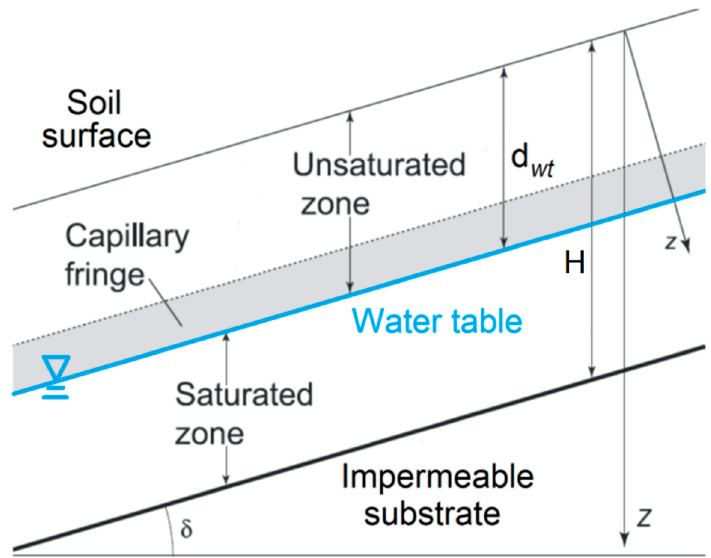
Figure 3. Conceptual sketch of the hydrological model in TRIGRS (modified from [22]). Table 1. Input parameters for the TRIGRS model.